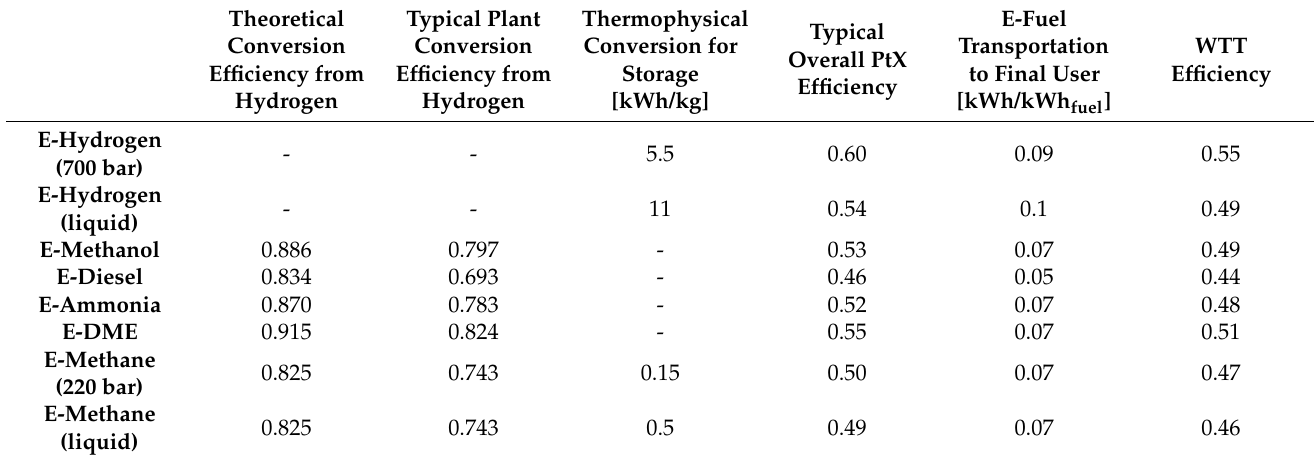
Table 7. E-fuel pathways from synthesis to vehicle tank. Based on [52,59–61].